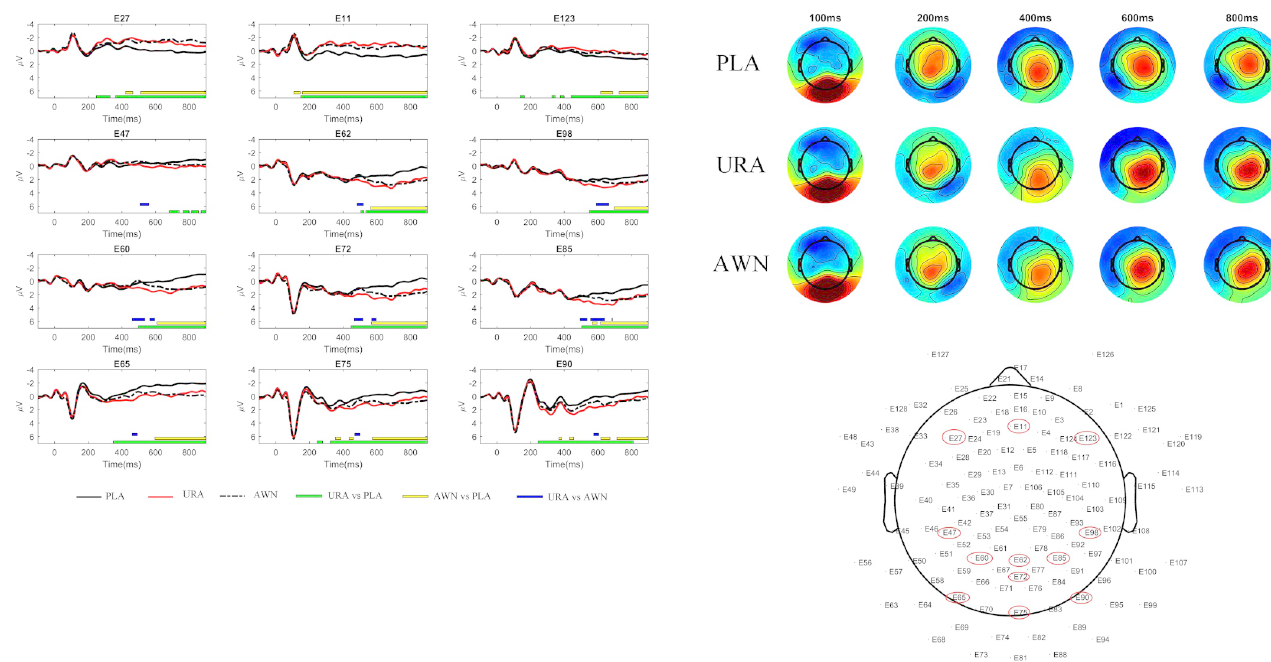
Fig 4. FRPs to the target words. Left Panel: FRPs from the first fixation on the target word on selected channels (E11, E27, E47, E60, E62, E65, E72, E75, E85, E90, E98 and E123 of the GSN-Hydrocel 128-channel cap (Electrical Geodesics Ltd)). Coloured bars under each channel highlight time-points with significant differences that belong to a cluster in the nonparametric permutation test. Right Panel: the associated topographies (all channels) over time in 12- to 13-5-year- old children (N = 66). The zero time-point is the onset of the first fixation on the target word.